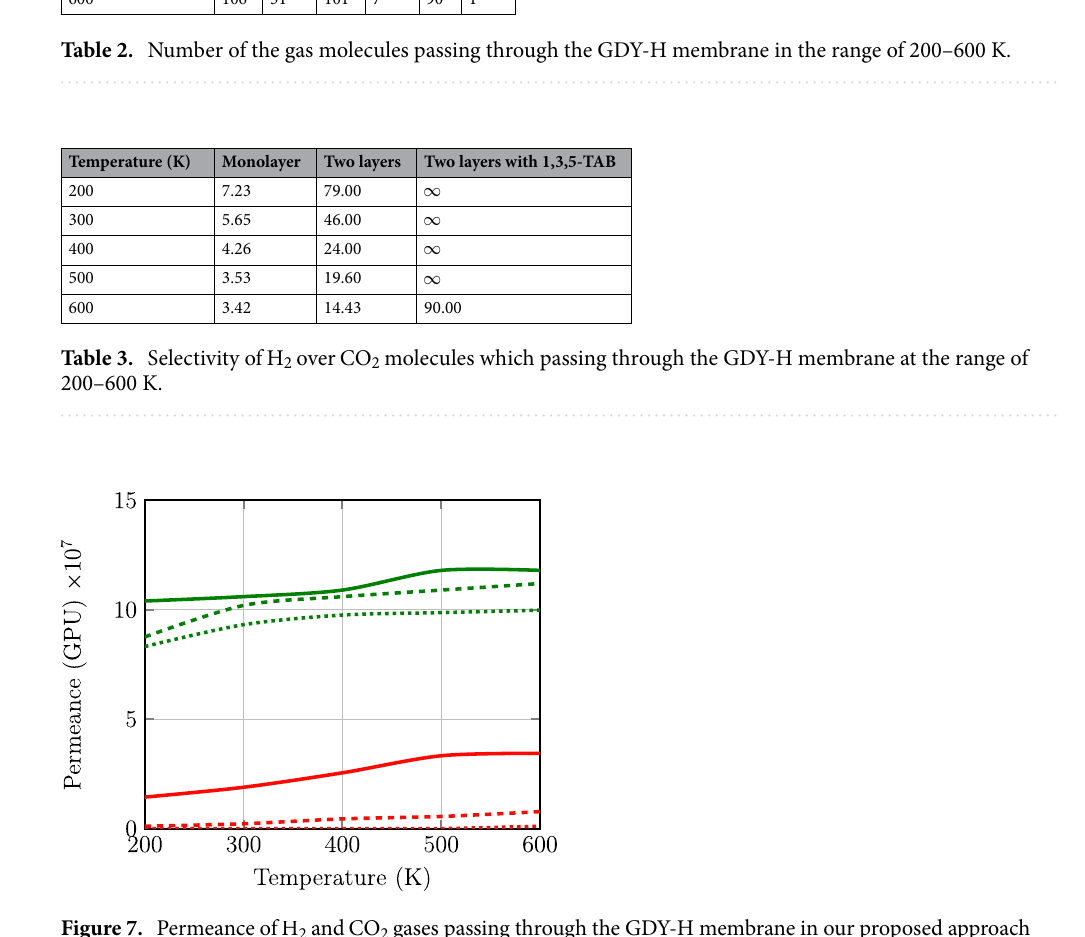
10 − 10 mol / m 2 sPa 70 ×